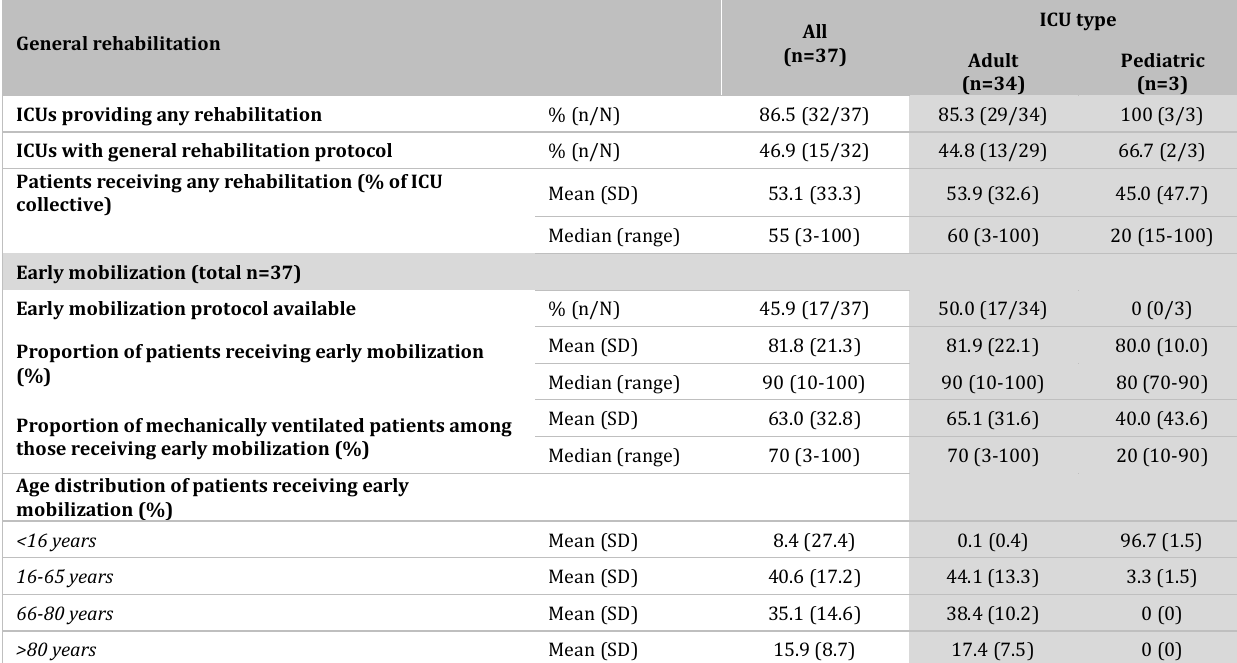
Table S4. General rehabilitation approaches and early mobilization in participating intensive care units (by ICU